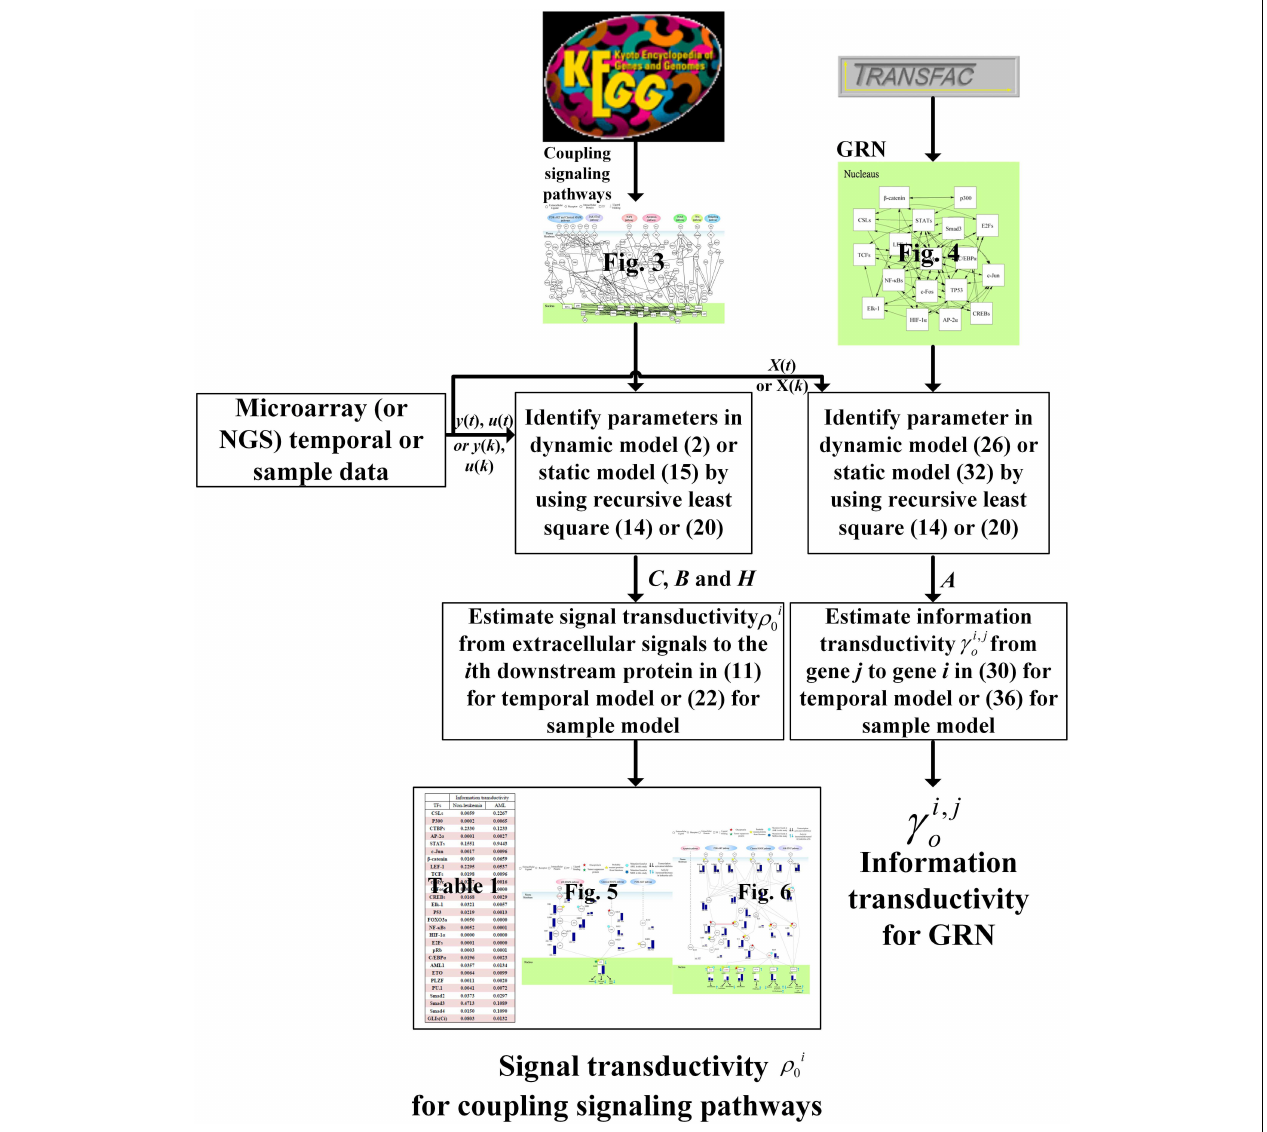
FIGURE 7 | The estimation flowchart of the signal transductivity for coupling signaling pathways and information transductivity for a GRN. The figure summarizes parameter estimations and transductivity measurements of information flows in this